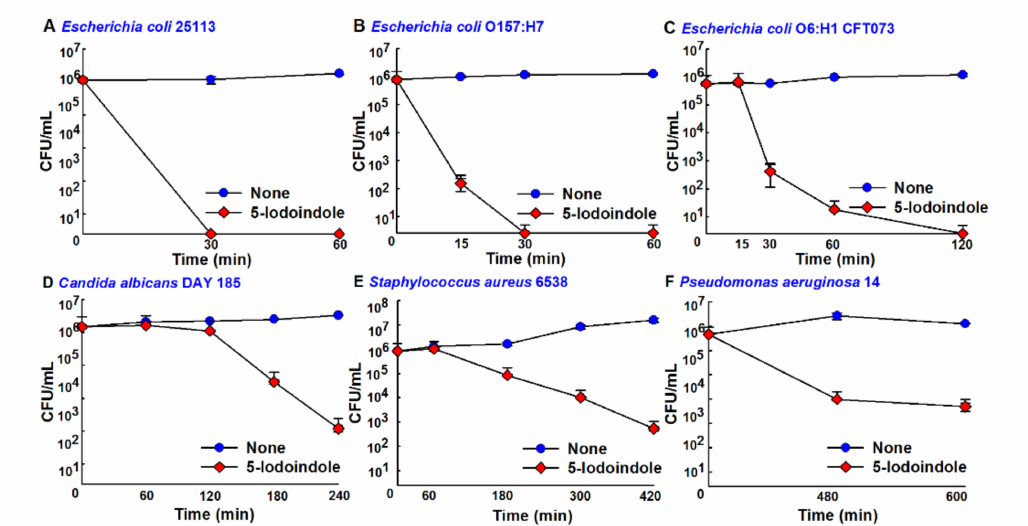
Figure 7. Rapid killing of other microbes by 5-iodoindole. ( A ) E. coli BW25113; ( B ) E. coli O157:H7; ( C ) E. coli O6:H1 CFT073; ( D ) C. albicans DAY185; ( E ) S. aureus ATCC 6538; ( F ) P. aeruginosa 14 cultures were treated with 5-iodoindole at 486 µ g / mL. At the indicated time points, aliquots of treated cells were plated and CFUs were enumerated. Error bars represent standard deviation.